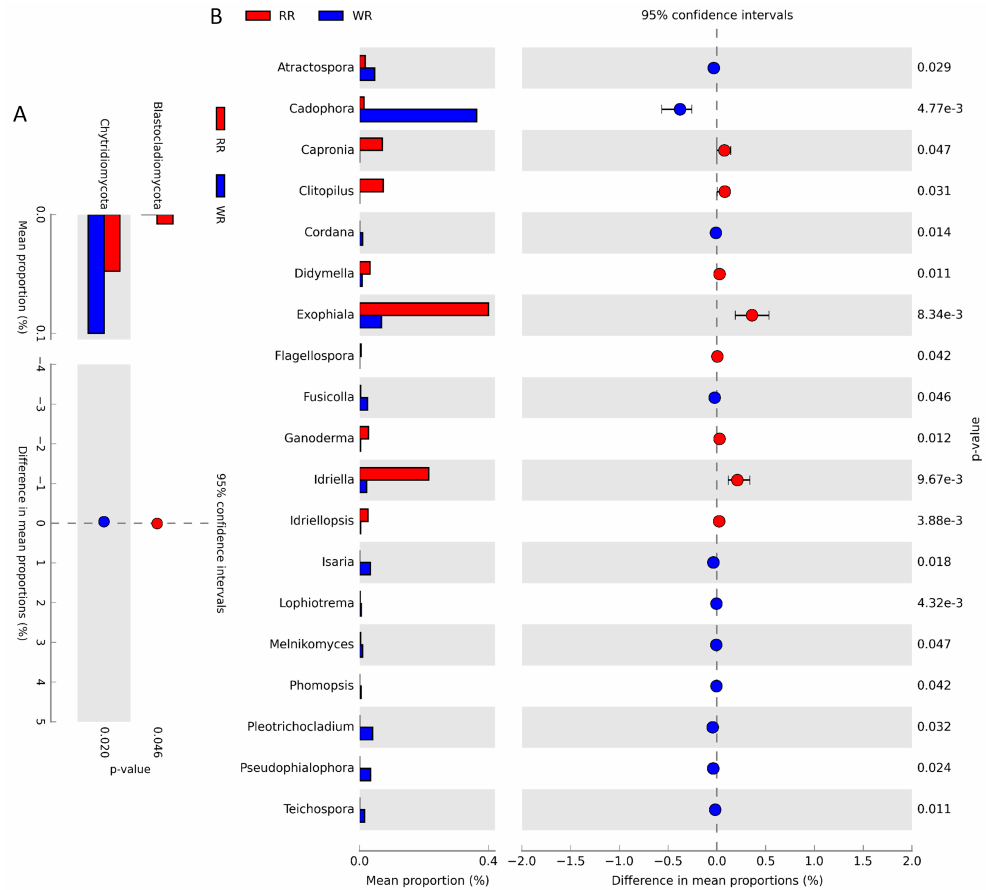
Figure 4. Comparison of fungal abundance in rhizospheric soil from wild (WR) and reintroduced (RR) M. sinica using White’s non-parametric t -test at the phylum ( A ) and genus ( B ) level (rhizospheric soil samples from wild plants (WR, n = 3); rhizospheric soil samples from reintroduced plants (RR, n = 3).